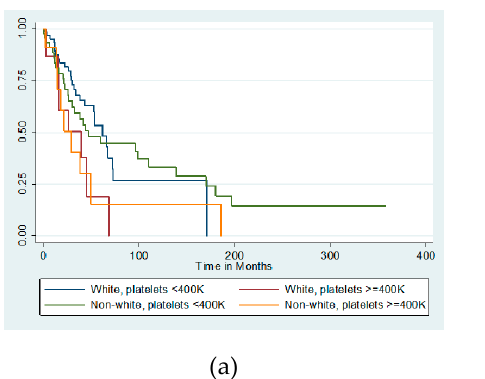
Table 3. Cox proportional hazards models for overall survival among patients with uterine serous carcinoma .